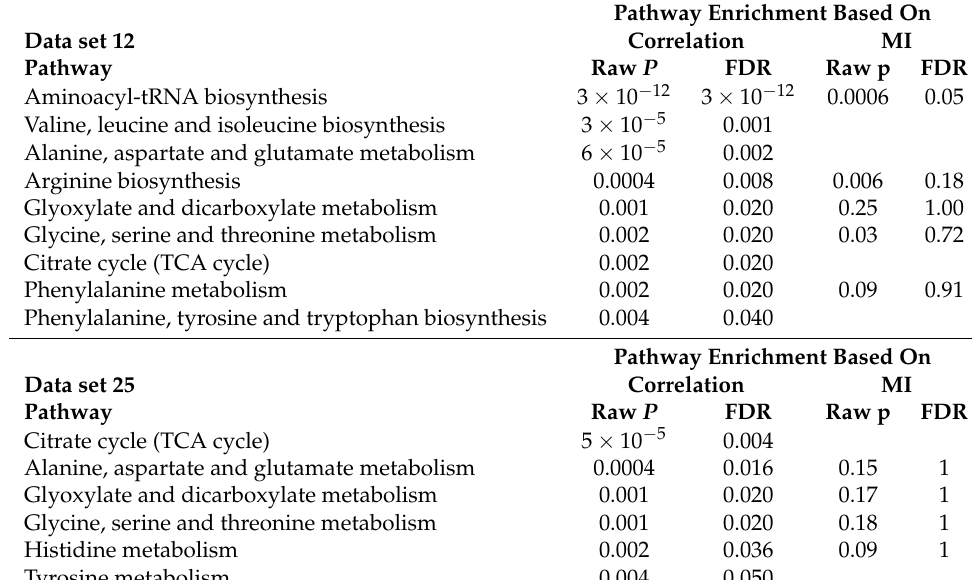
Table 2. Results of pathway enrichment for data set 12 and 25 from Table 1 based on the sets of metabolite found to be differentially connected using correlation or MI as measure of metabolite-metabolite association. FDR: False discovery rate. Empty cells indicate that no metabolite was found to be associated with the given